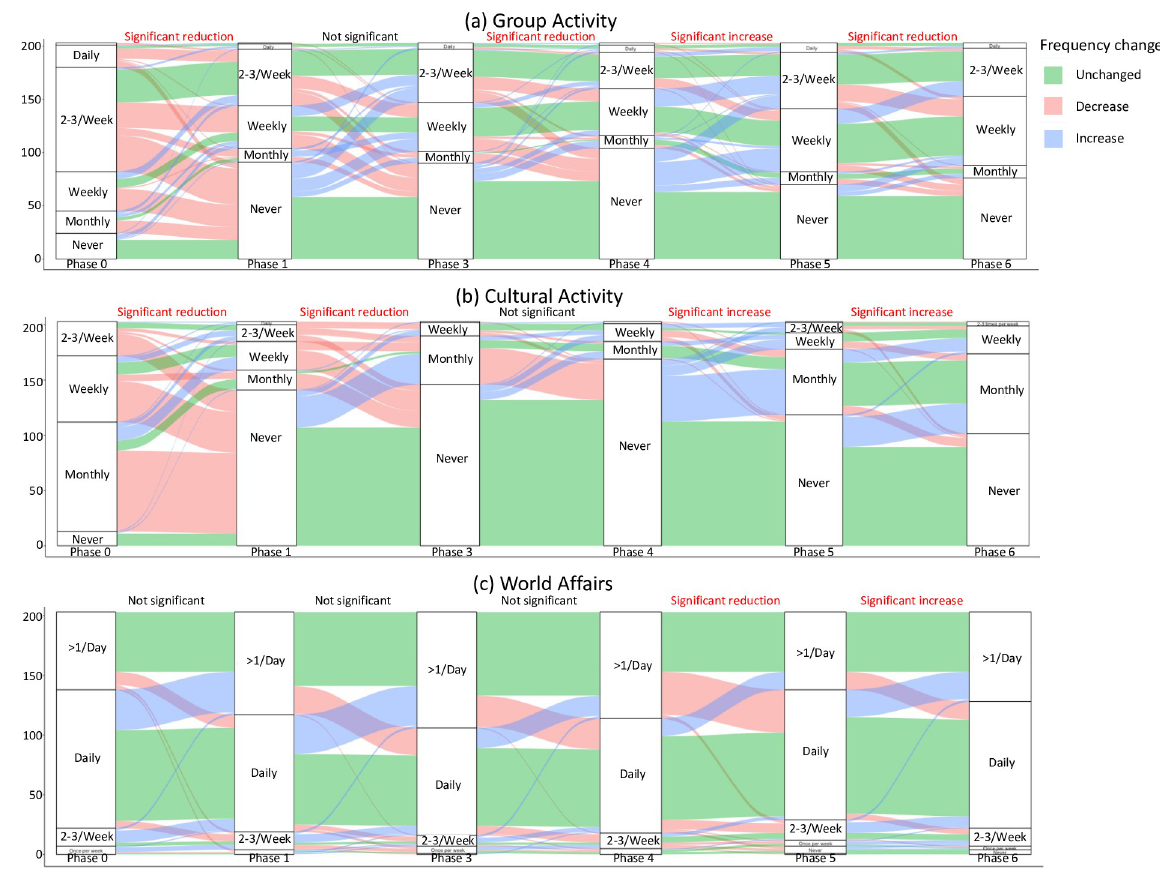
Fig 5. Examples of alluvial plots indicating frequency change of people performing group activity, cultural activity and keeping up with world affairs among the repeated measures (N = 203) throughout the five phases (phase 2 was left out of the analysis due to insufficient samples); P-values were calculated by one-sample Wilcoxon signed-rank test to determine significance in changes on phase to phase basis; see S2 File for all